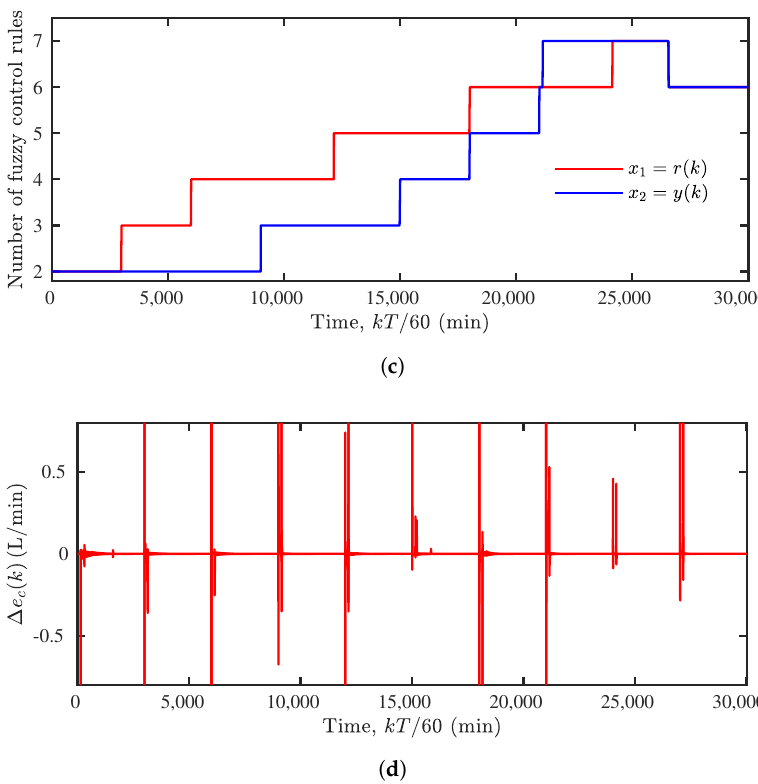
Figure 4. Results of the proposed self-evolving FLC design methodology on the CSTR plant. ( a ) Results of the proposed methodology, and of the SEDFLC method [31]. ( b ) Command signal of the proposed method and of the SEDFLC method [31]. ( c ) Evolution of the number of fuzzy control rules. ( d ) Evolution of ∆ e c ( k ) .